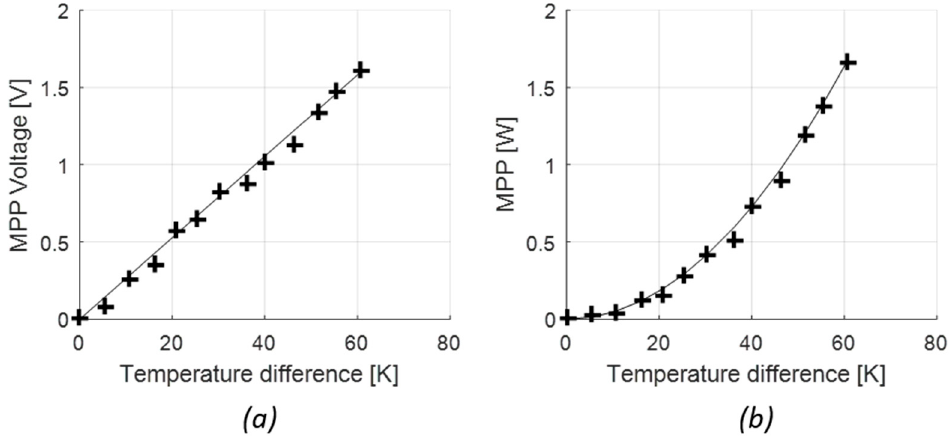
Figure 21. Experimental characteristic curves. ( a ) V– Δ T curve ( b ) P– Δ T curve.